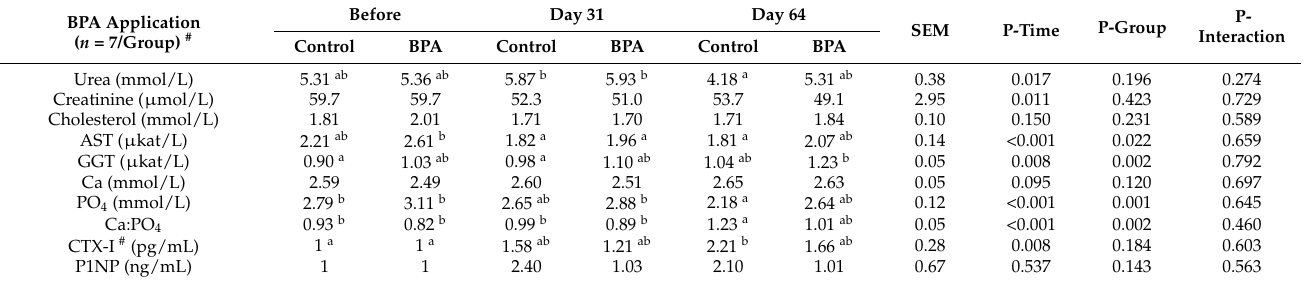
Table 1. Serum concentration of bone turnover markers of rams in the BPA and control groups. The BPA group received 25 µ g BPA/kg bw/day for 64 days. Values are given as least square means, except in CTX-I and P1NP, where the relative values were